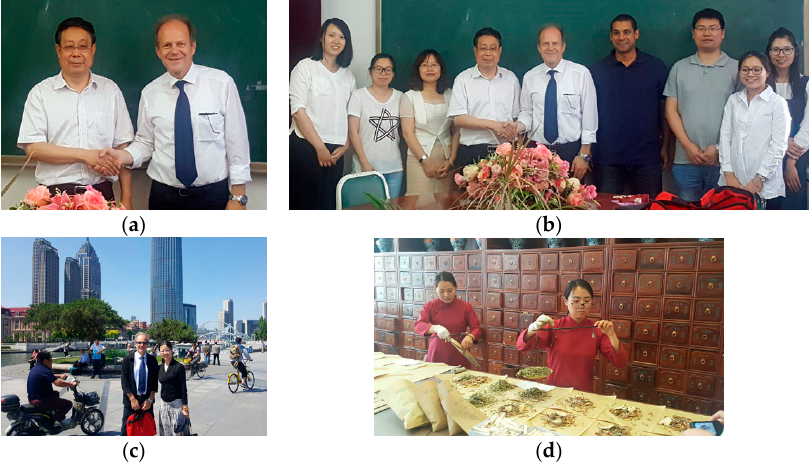
Figure 8. Tianjin University of Chinese Medicine (TUCM). Professor Guo Yi with Professor Gerhard Litscher ( a ). Acupuncture Seminar ( b ). Tianjin, China. Professor Song Ping, China Academy of Chinese Medical Sciences with Professor Gerhard Litscher ( c ), TUCM ( d ), 23 May 2017.